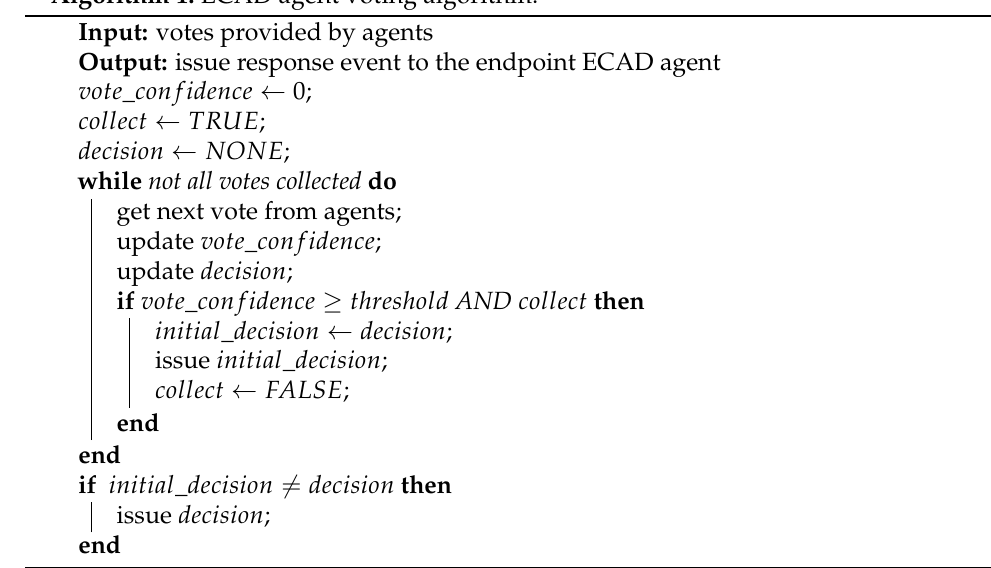
Algorithm 1: ECAD agent voting